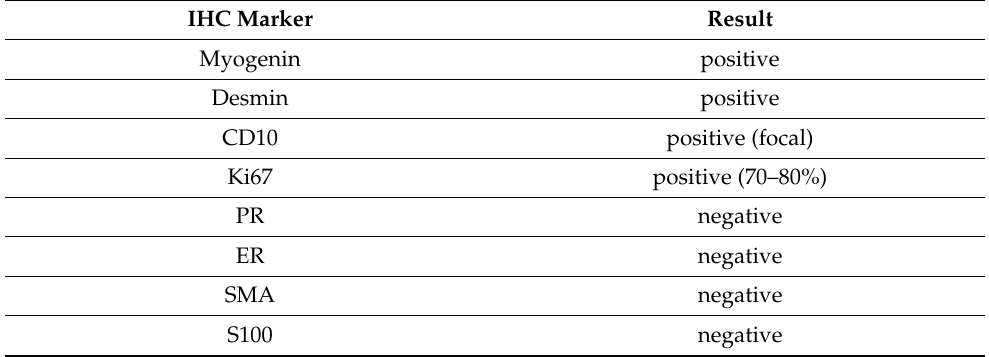
Table 1. Immunohistochemistry findings in histopathological examination of the excised tissues.